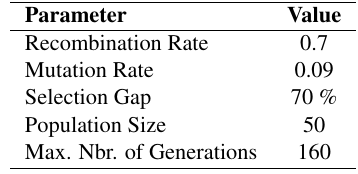
Table 1. Parameter Description of